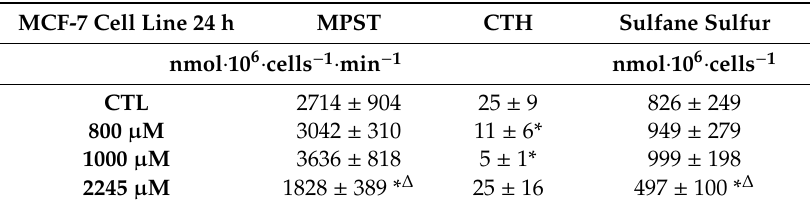
Table 2. The mean value of MPST, CTH activity and sulfane sulfur level in the MCF-7 cell line after a 24 h incubation with SAC.